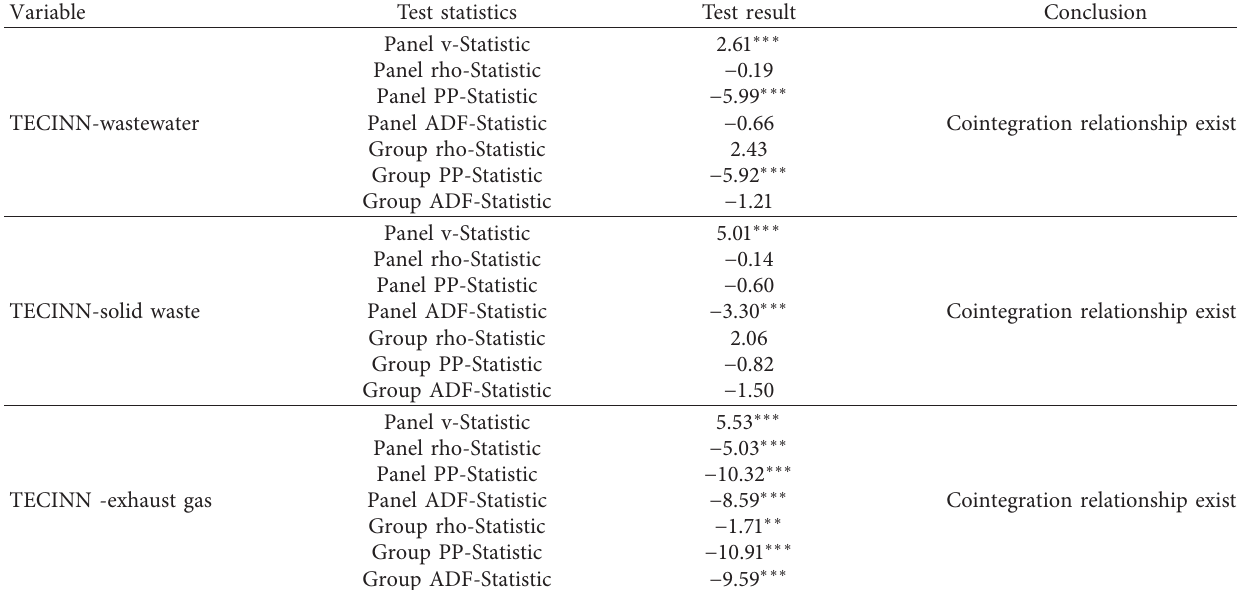
Table 5: Results of cointegration root